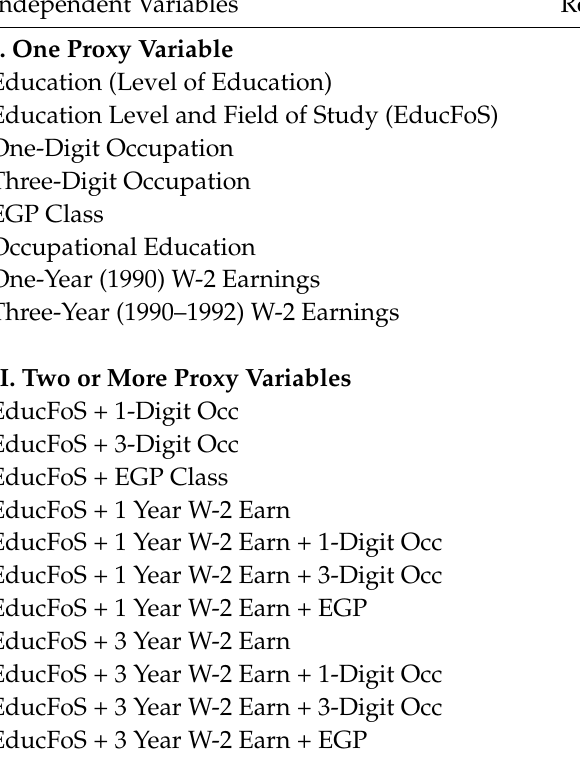
Table 2: Results for OLS models of log–long-term earnings, men. Independent